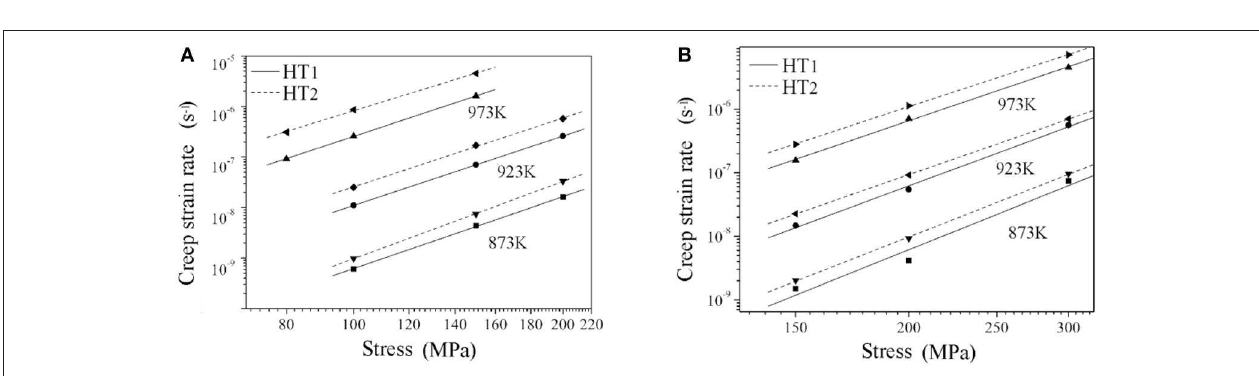
FIGURE 8 | Curve of logarithmic creep strain rates–logarithmic stress at different temperatures. (A) Matrix alloy. (B) TMCs.